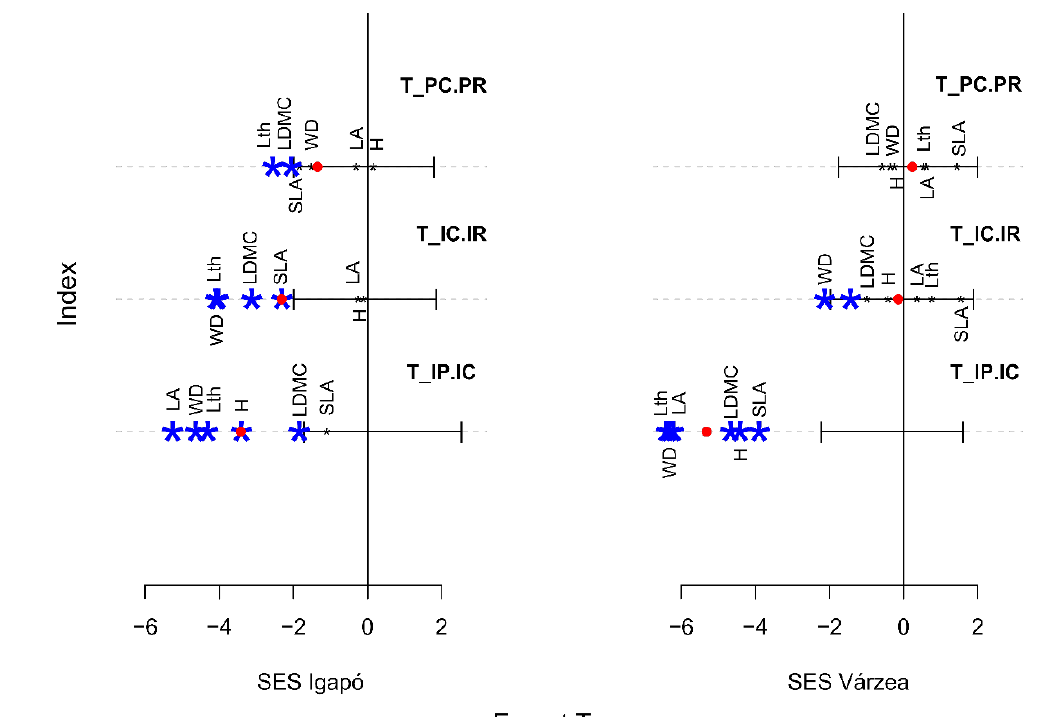
Figure 5. Standardized effect size (SES) of the six functional traits evaluated for three T statistics according to each forest type. The T statistics evaluated are (1) T_IP.IC: observed ratio between the variance of the populations and the total variance of the communities at the individual level; (2) T_IC.IR: observed ratio between the variance of each community and the total variance of the regional pool at the individual level; (3) T_PC.PR: observed ratio between the variance of each community and the total variance of the regional pool at the population level. The segments observed in each figure represent the expected random ranges corresponding to each T statistic. Blue asterisks indicate significantly lower differences compared to the null models ( p < 0.05). Red dots show the average SES of all traits for each T statistic.